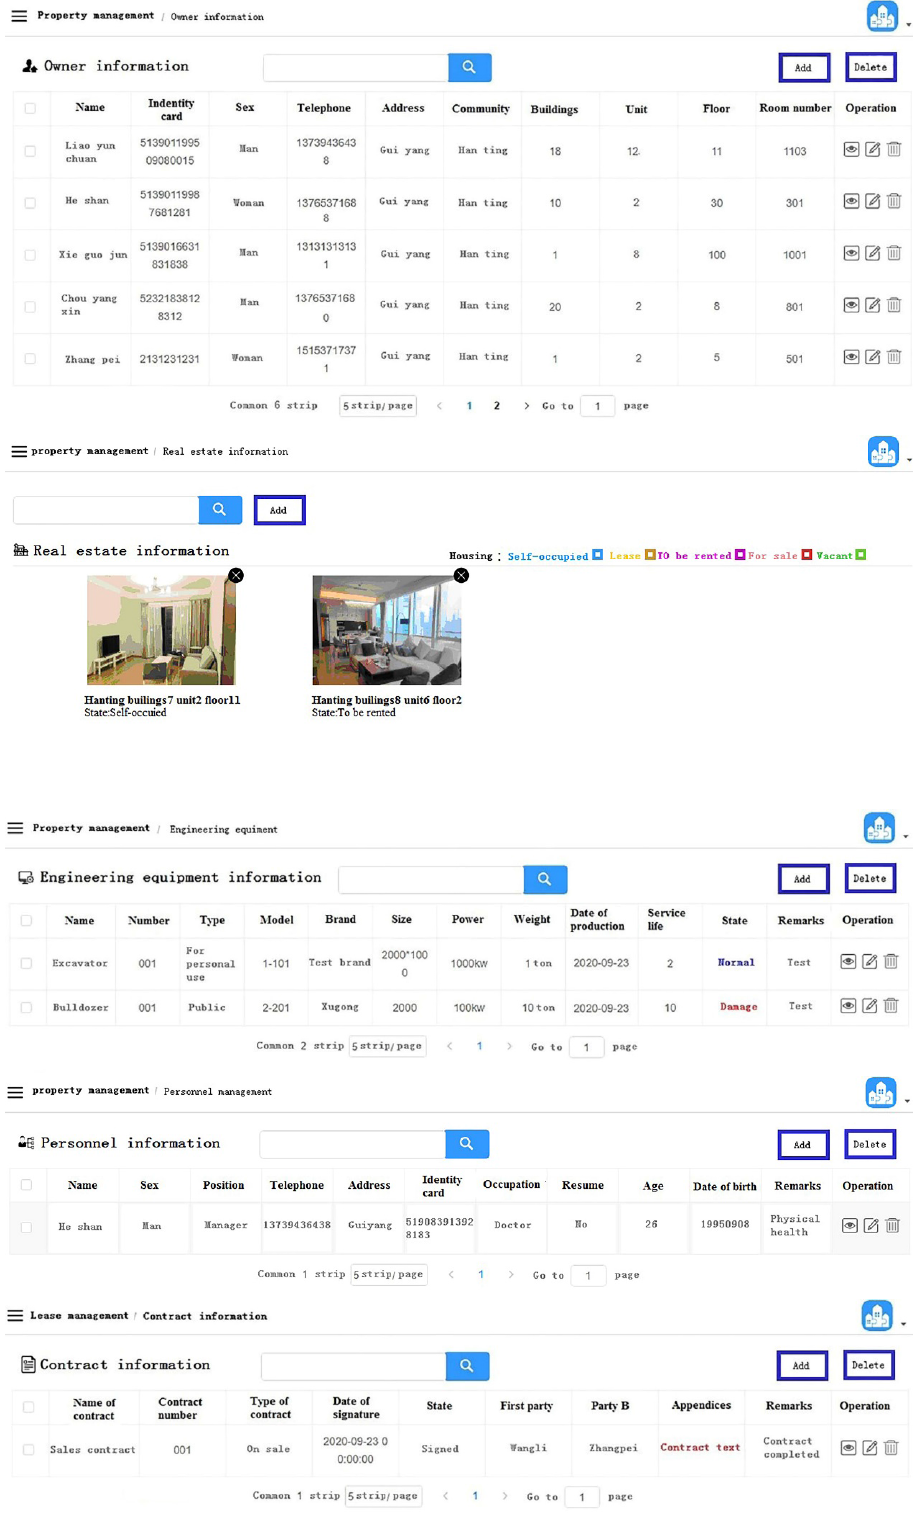
Fig. 5 Data management interface of a residential